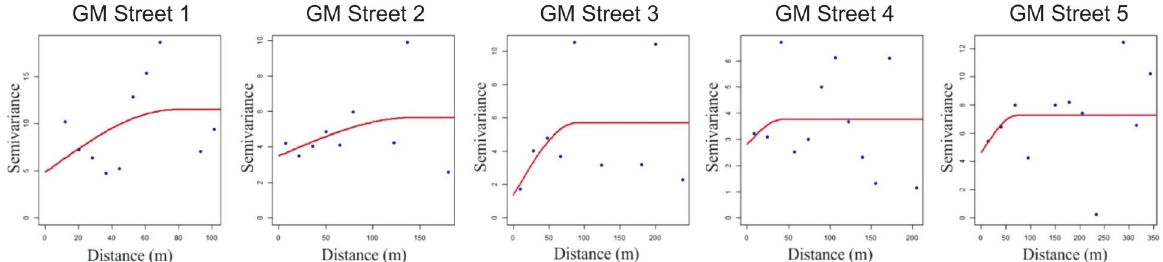
Figure 3. Semivariograms resulting from the OLS fitting aggregated with visual recognition of the spherical model structures in its relationship with the semivariances for GM, per coffee